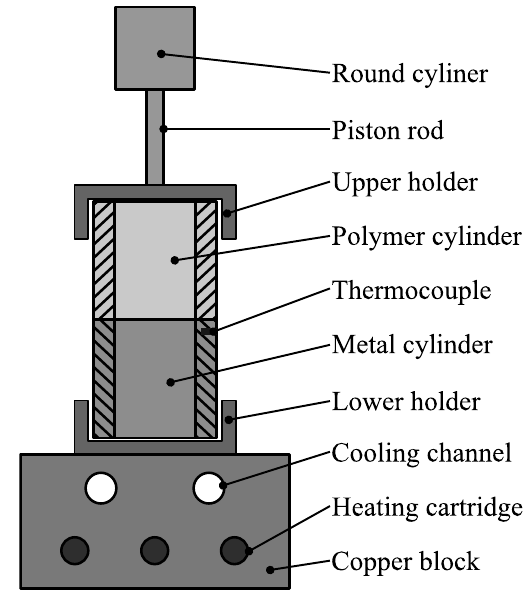
Figure 3. Hot pressing tool.